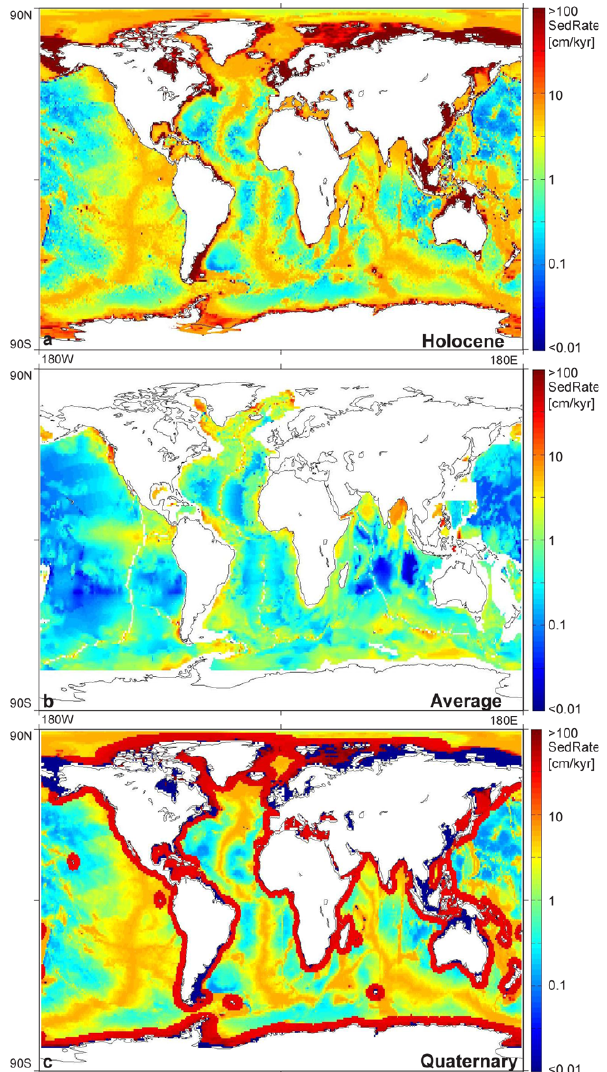
Fig. 2. Distribution maps of the sedimentation rate (SR) calculated following: (a) Approach #1 for the Holocene; (b) Approach #2 for averaged values over geological times; and (c) Approach #3 for the Quaternary; note the logarithmic scale